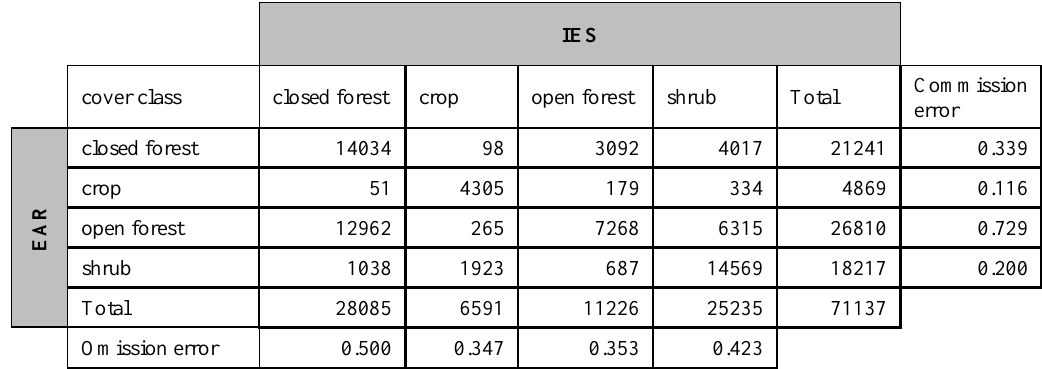
Table 4. Confusion matrix of EAR and IES classifications